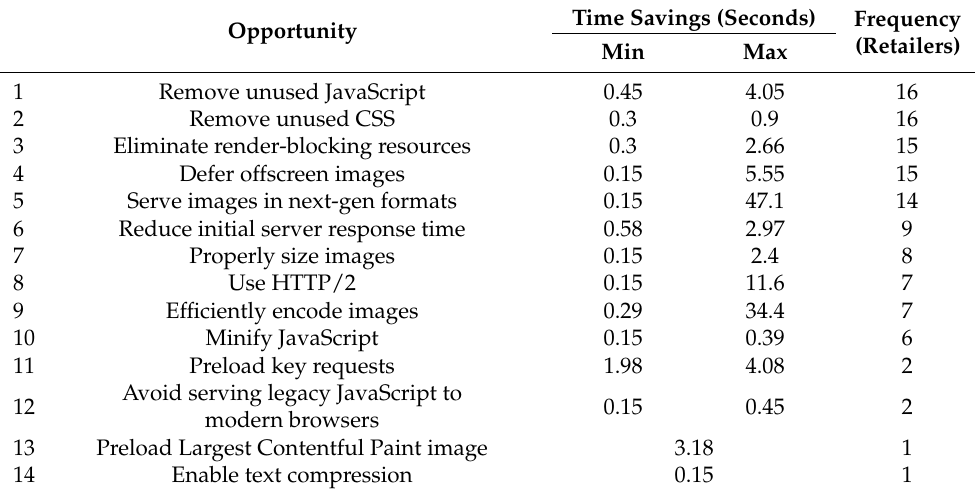
Table 1. The opportunities for retailers and time savings once implemented.